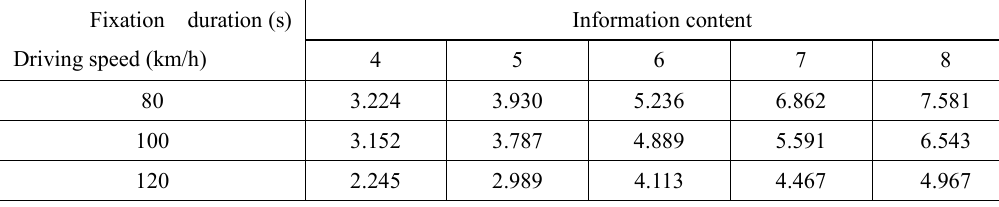
Table 3 Acceleration on different information content with changed speeds